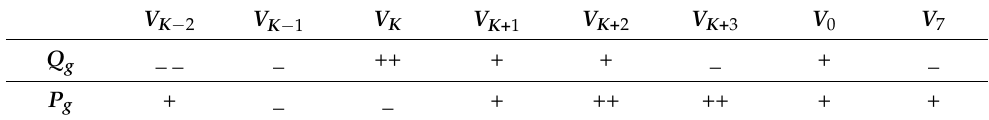
Table 5. Instantaneous variations of active and reactive powers due to applied voltage vectors.